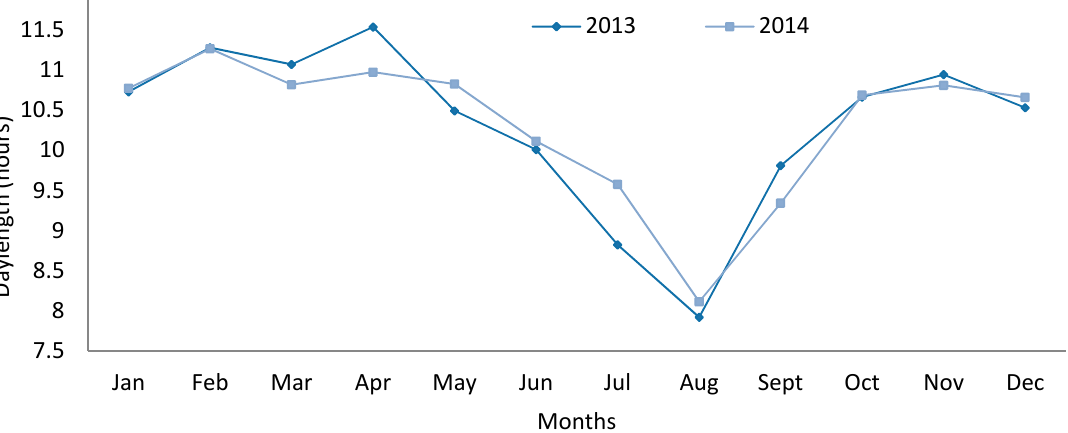
Figure 3. Average monthly daylength in 2013 and 2014 growing seasons for dry-season sorghum at Youé research farms in Chad.